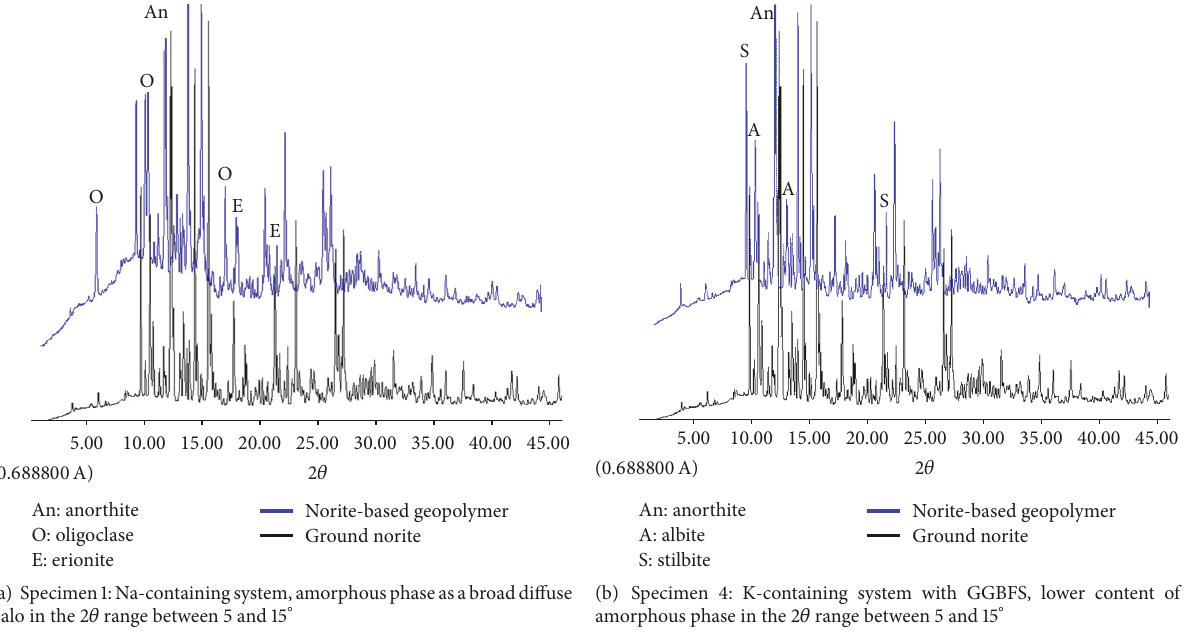
Figure 5: X-ray patterns of the norite-based binders cured for 7 days at 87 ∘ C and ambient pressure.